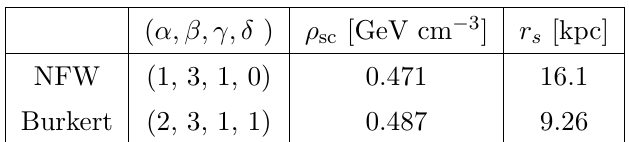
Table 1. The value of parameters associated with the NFW and Burkert pro(cid:12)les are listed here. They are same as in ref.